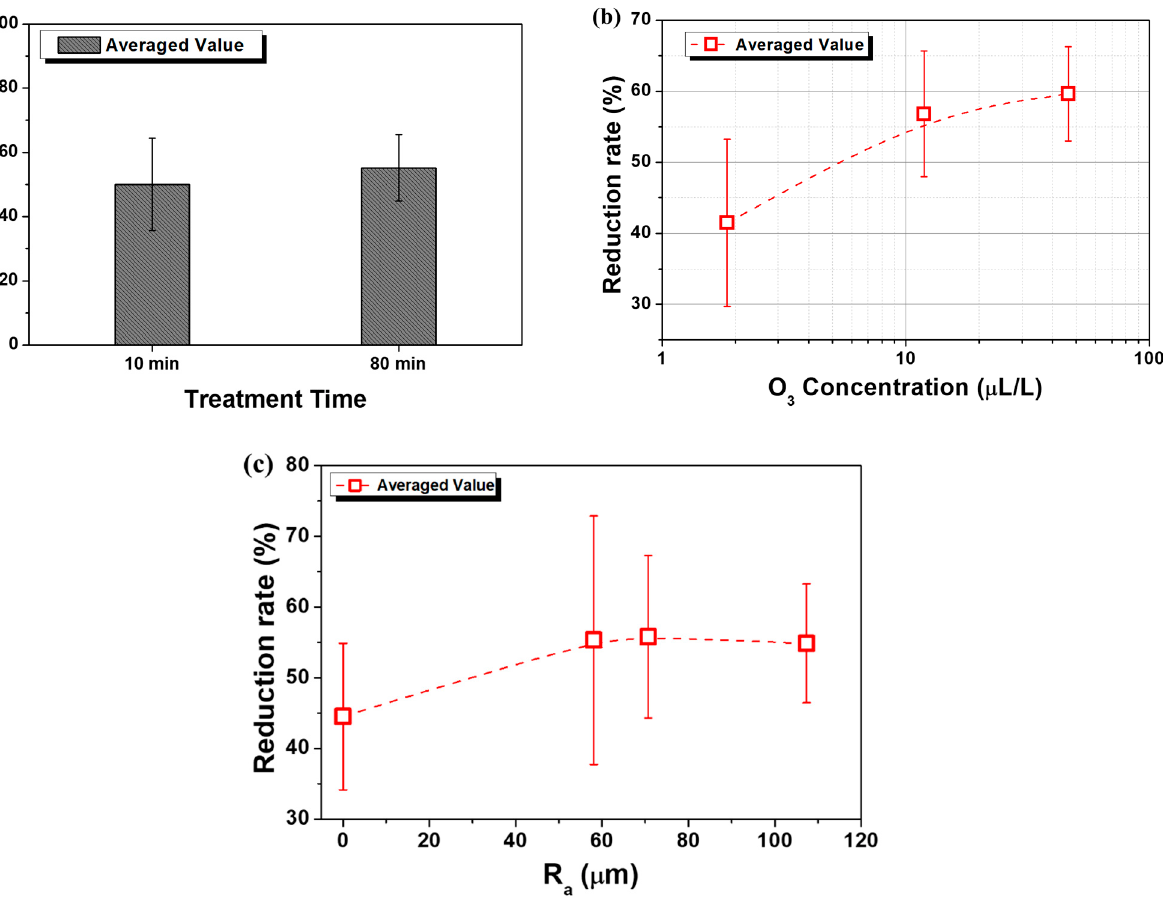
Figure 6. Averaged reduction rates of plasma treated fludioxonil depending on different ( a ) treatment times, ( b ) O 3 concentrations, and ( c ) R a values. All values represent the mean and error bars represent the standard deviation of three repeated measurements.